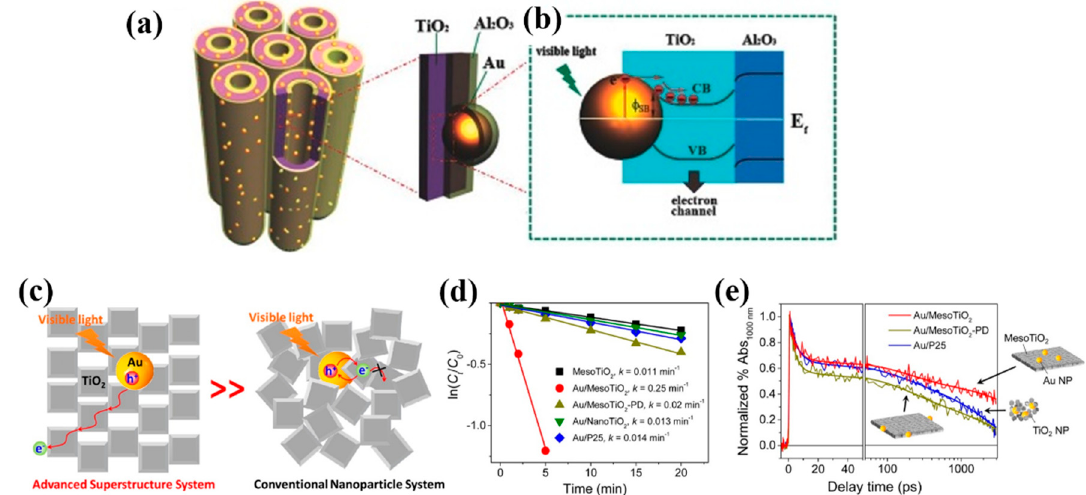
Figure 9. The methods to separate charges transported to the interface. ( a ) The scheme of TiO 2 nanotube-Al 2 O 3 -Au and ( b ) the process of transfer of HCs under visible light illumination. ( a , b ) Reproduced with permission. [101] Copyright 2015, Wiley-VCH. ( c ) The scheme of the flowing of HCs in ordered Au-TiO 2 structures and that in random structures. ( d ) The rates of degradation of MB and ( e ) the life of HCs observed at 1000 nm in di ff erent Au / TiO 2 systems. ( c – e ) Reproduced with permission. [102] Copyright 2014, American Chemical Society.